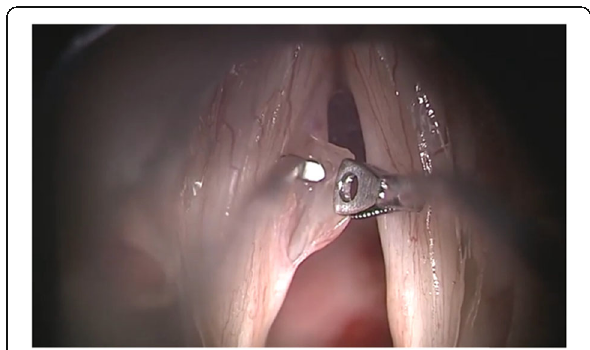
Fig. 1 Endoscopic view of laryngeal left vocal cord nodule during forceps excision